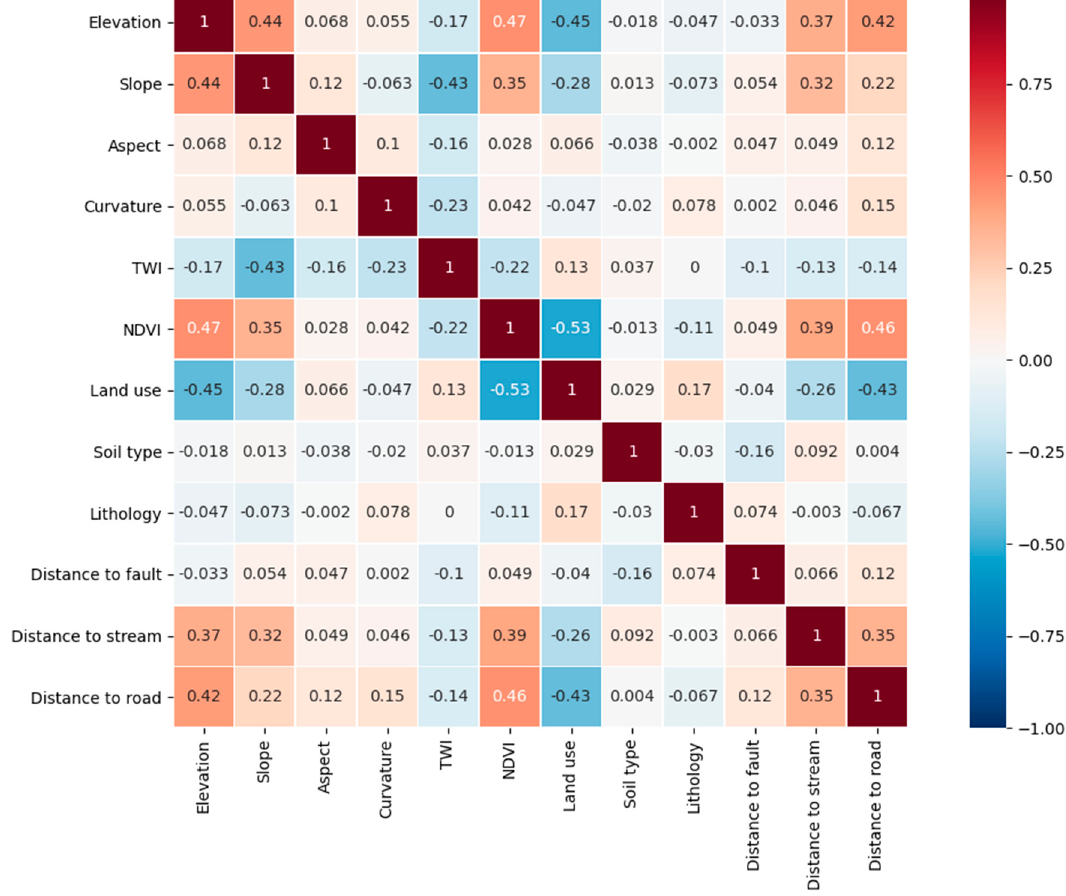
Figure 8. The output results of the Pearson correlation matrix.